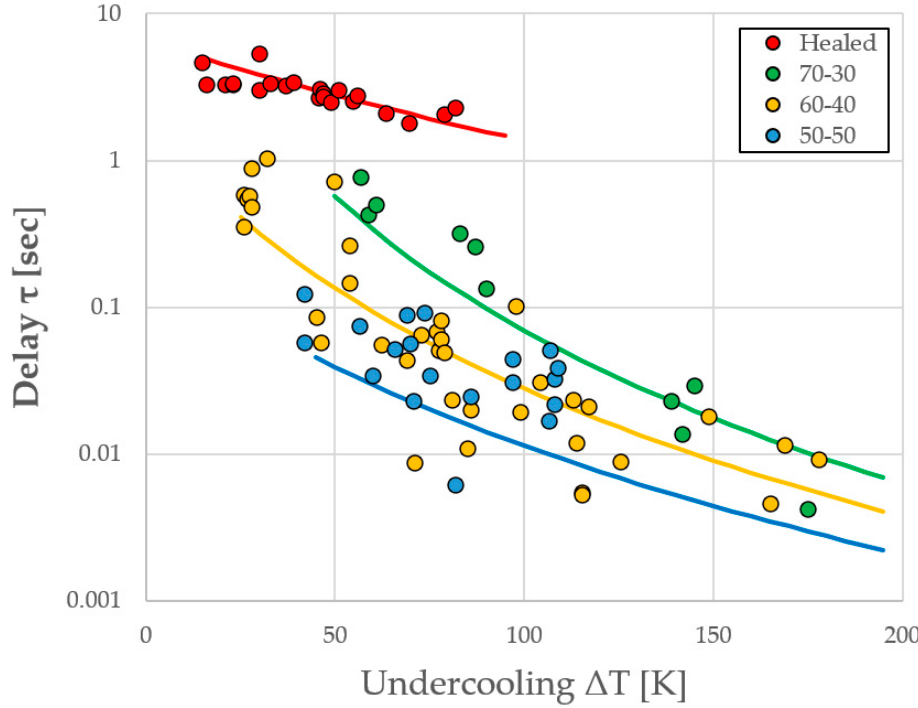
Figure 3. Experimentally observed delay time as a function of undercooling ( ∆ T = ∆ T s + ∆ T m ) for the three alloys studied with RDM predictions of behavior, assuming an attachment rate of β = 2 × 10 8 atoms/s.